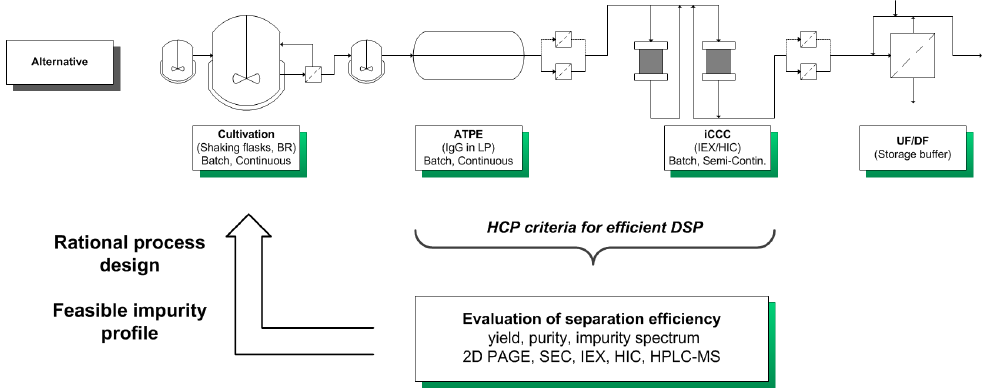
Figure 4. USP DSP integration approach for a systematic development of a bioprocess.